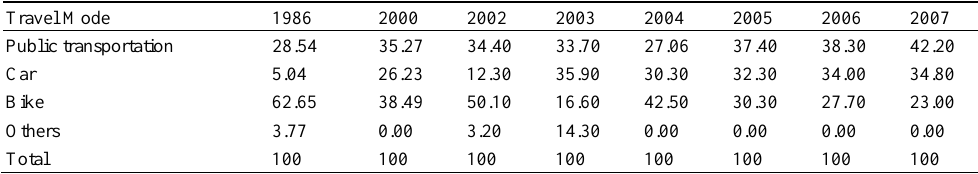
Table 6: Travel modes in Beijing from 1986 to 2007 （ % ）